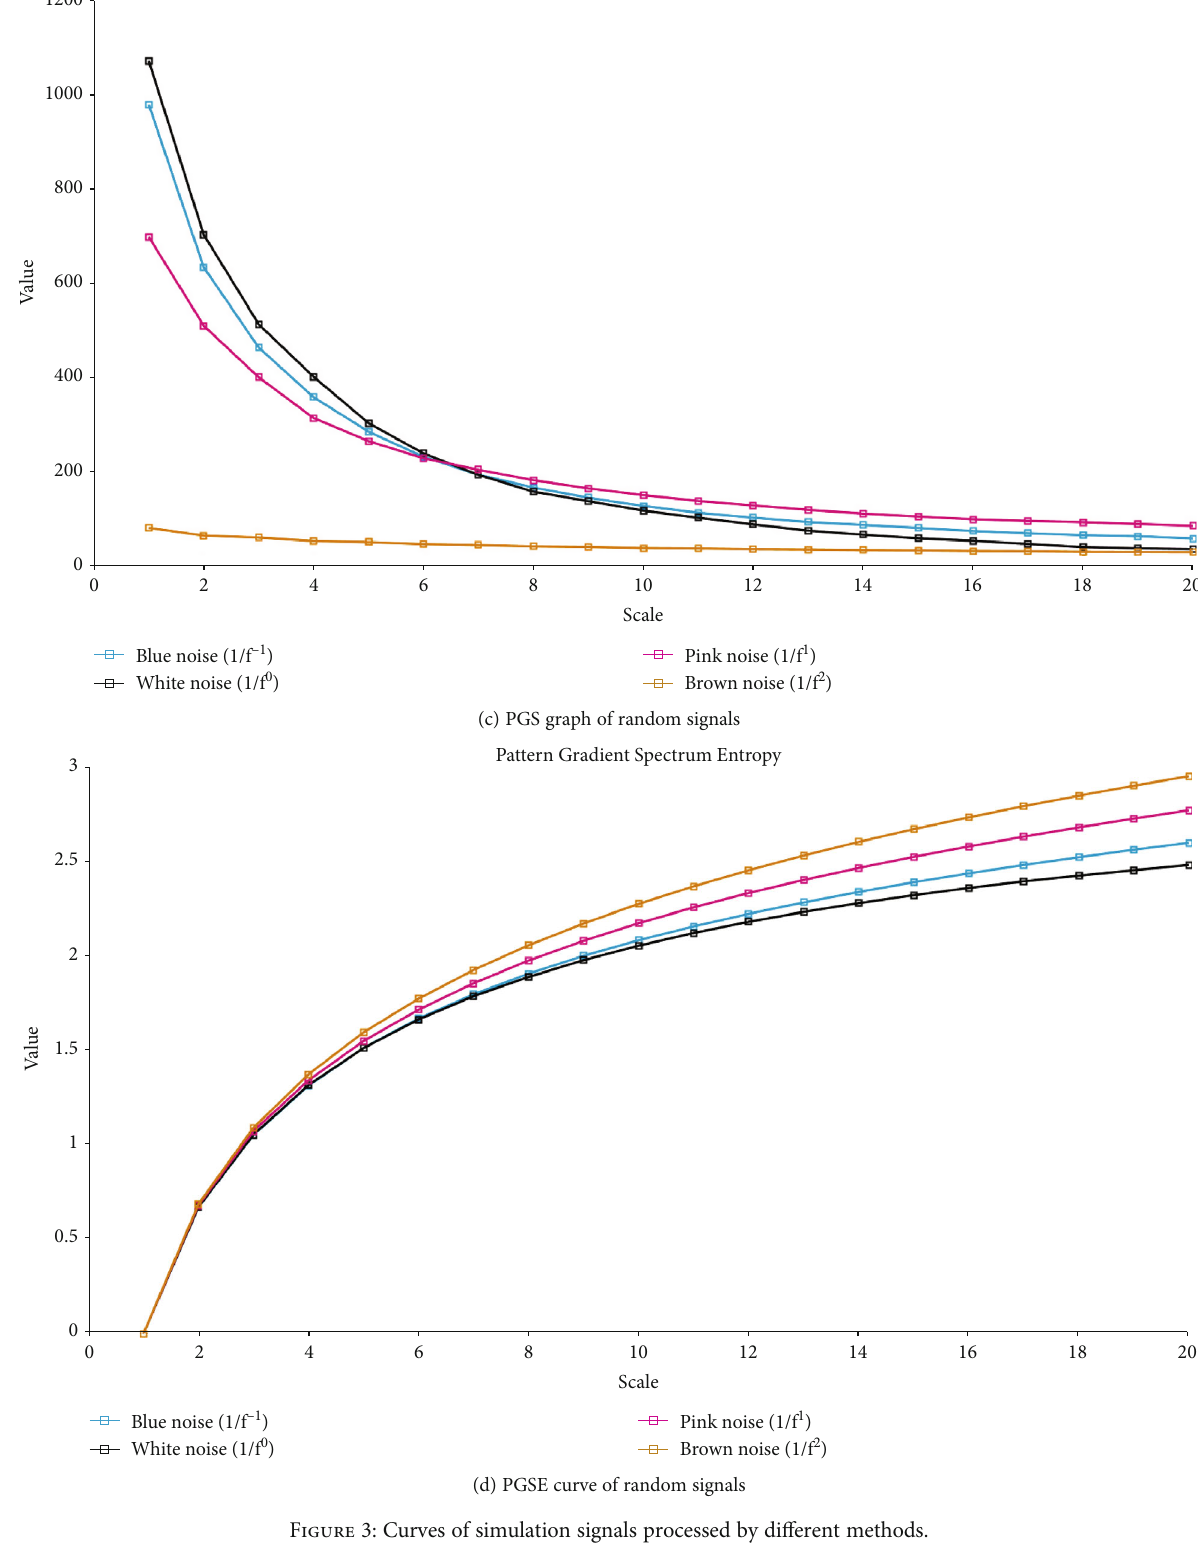
Figure 3: Curves of simulation signals processed by di ff erent